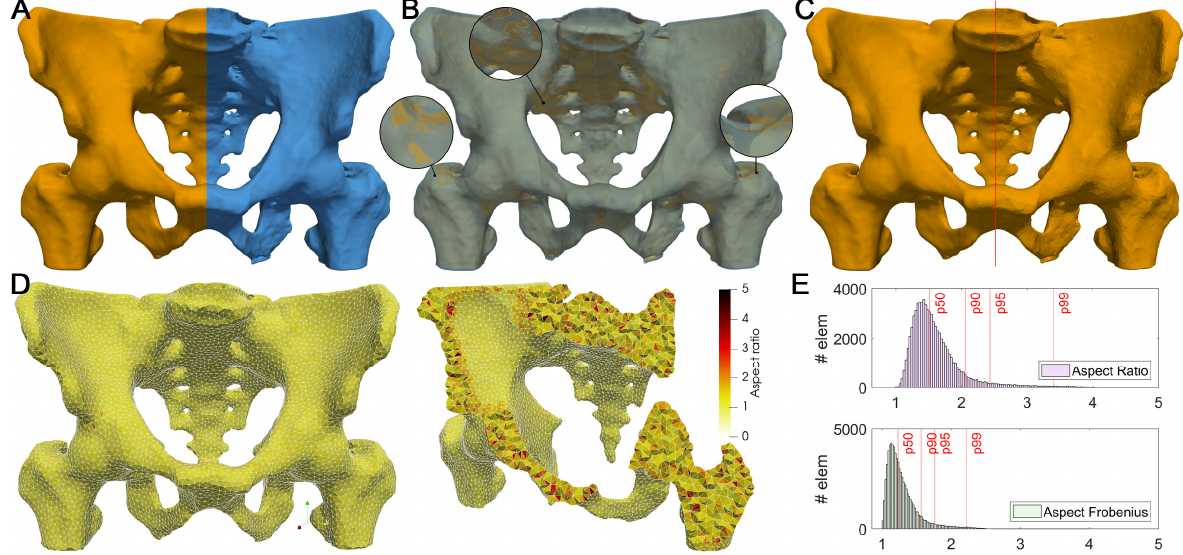
Figure 3. Reconstruction of the partial segmentation of a human pelvis: ( A ) reconstruction of the pelvis using im2mesh (left, orange) and 3D Slicer (right, blue); ( B ) volumetric overlap of the two reconstructions with decreased opacity for better visualisation (same colours). Insets highlight the zones where differences are more noticeable, corresponding with rough areas where the smoothing and triangulation algorithms play a bigger role. Nonetheless, the IoU score attained was 98.6%; ( C ) effect of decimating on the triangulated surface mesh: 5M triangles (left) vs. 50 K (right). Despite visually reducing the smoothness, the IoU score attained (50 k vs. 5 M) was 97.8%; ( D ) volumetric mesh generated with 5 mm objective element size (total number of elements: 72,694), coloured by AR, showing very high quality (>90% of the elements in the 1–2 range); ( E ) value distribution of the AR and AF metrics for mesh quality assessment. Vertical red lines mark the 50, 90, 95 and 99 percentiles, respectively. Additional mesh quality metrics of the pelvis mesh are presented in Appendix